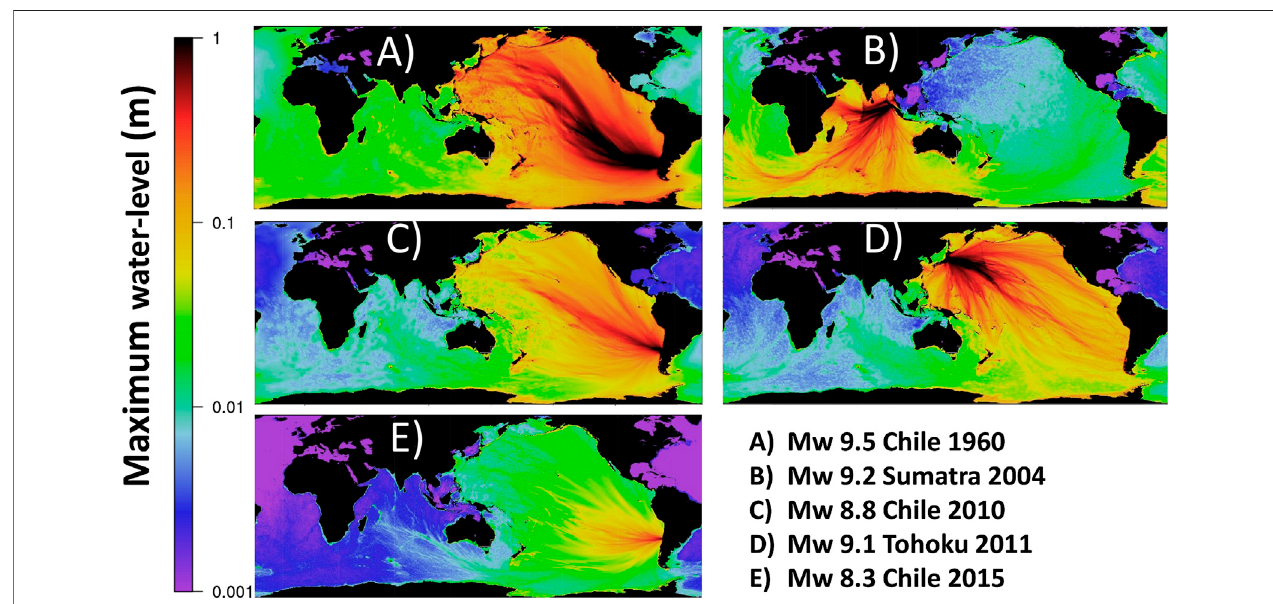
FIGURE1| Tsunami eventsconsidered inthisstudy. Theimagesaremodel outputs derivedusing thesolverfrom Section2.4.3 ontheglobal gridand asubsetof the source models in Figure 2 [ (A) : H19, (B) : F07, (C) : L11, (D) : Y18, (H) : W17].